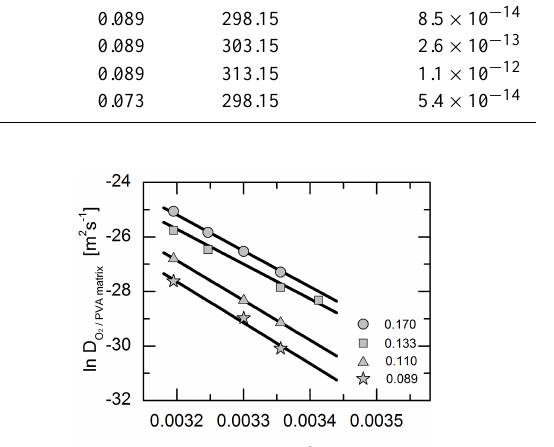
Figure 6. Influence of iron particles (iron mass fraction in the PVA/iron composite matrix of 0.045) on the MB concentration pro- file in PVA/iron composite films of 180µm thickness at 313.15K and RH of 80%. The symbols represent experimental data and the line is the modeling of the MB concentration profile in the absence of